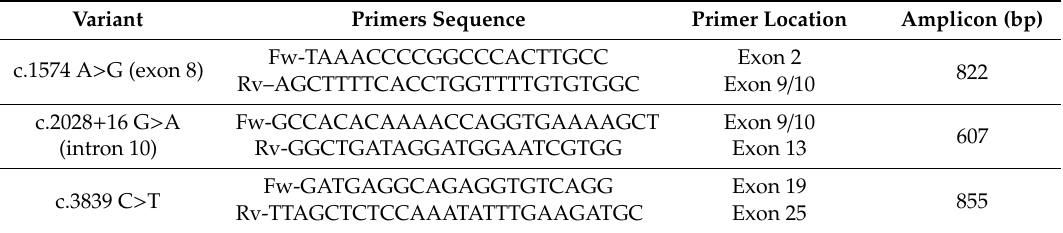
Table 7. Primers used for RT-PCR amplification of CLSPN transcripts containing c.1574A > G, c.2028 + 16 G > A and c.3839C > T